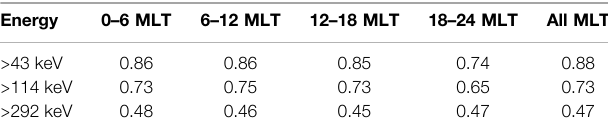
TABLE 1 | The Pearson correlation coef fi cient between daily resolved AE index and the logarithmic value of > 43 > 114, and > 292 keV loss cone fl uxes over the 55 ° – 70 ° CGM latitude band for the years 2004 –